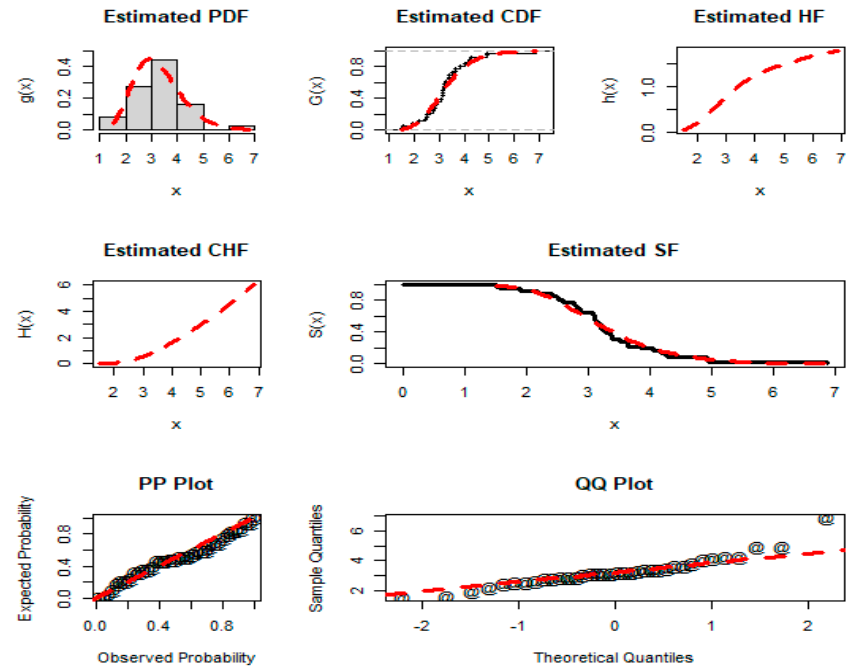
Figure 9. Estimated PDF, CDF, HF, CHF, SF, PP plot, and QQ plot of the NGLog–Weib distribution for dataset 3.